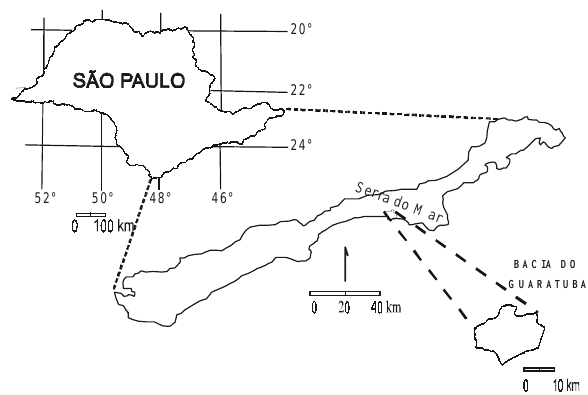
Figura 1. Mapa de localização da área de